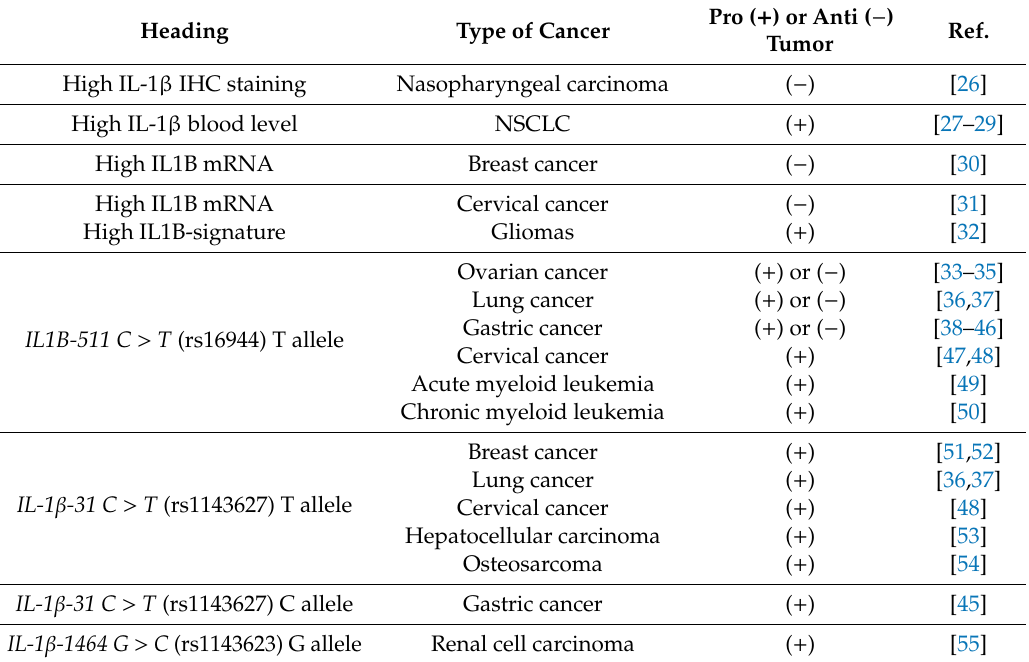
Table 1. E ff ects of interleukin (IL)-1 β or IL1B expression or IL1B polymorphisms on cancer. NSCLC, non-small cell lung